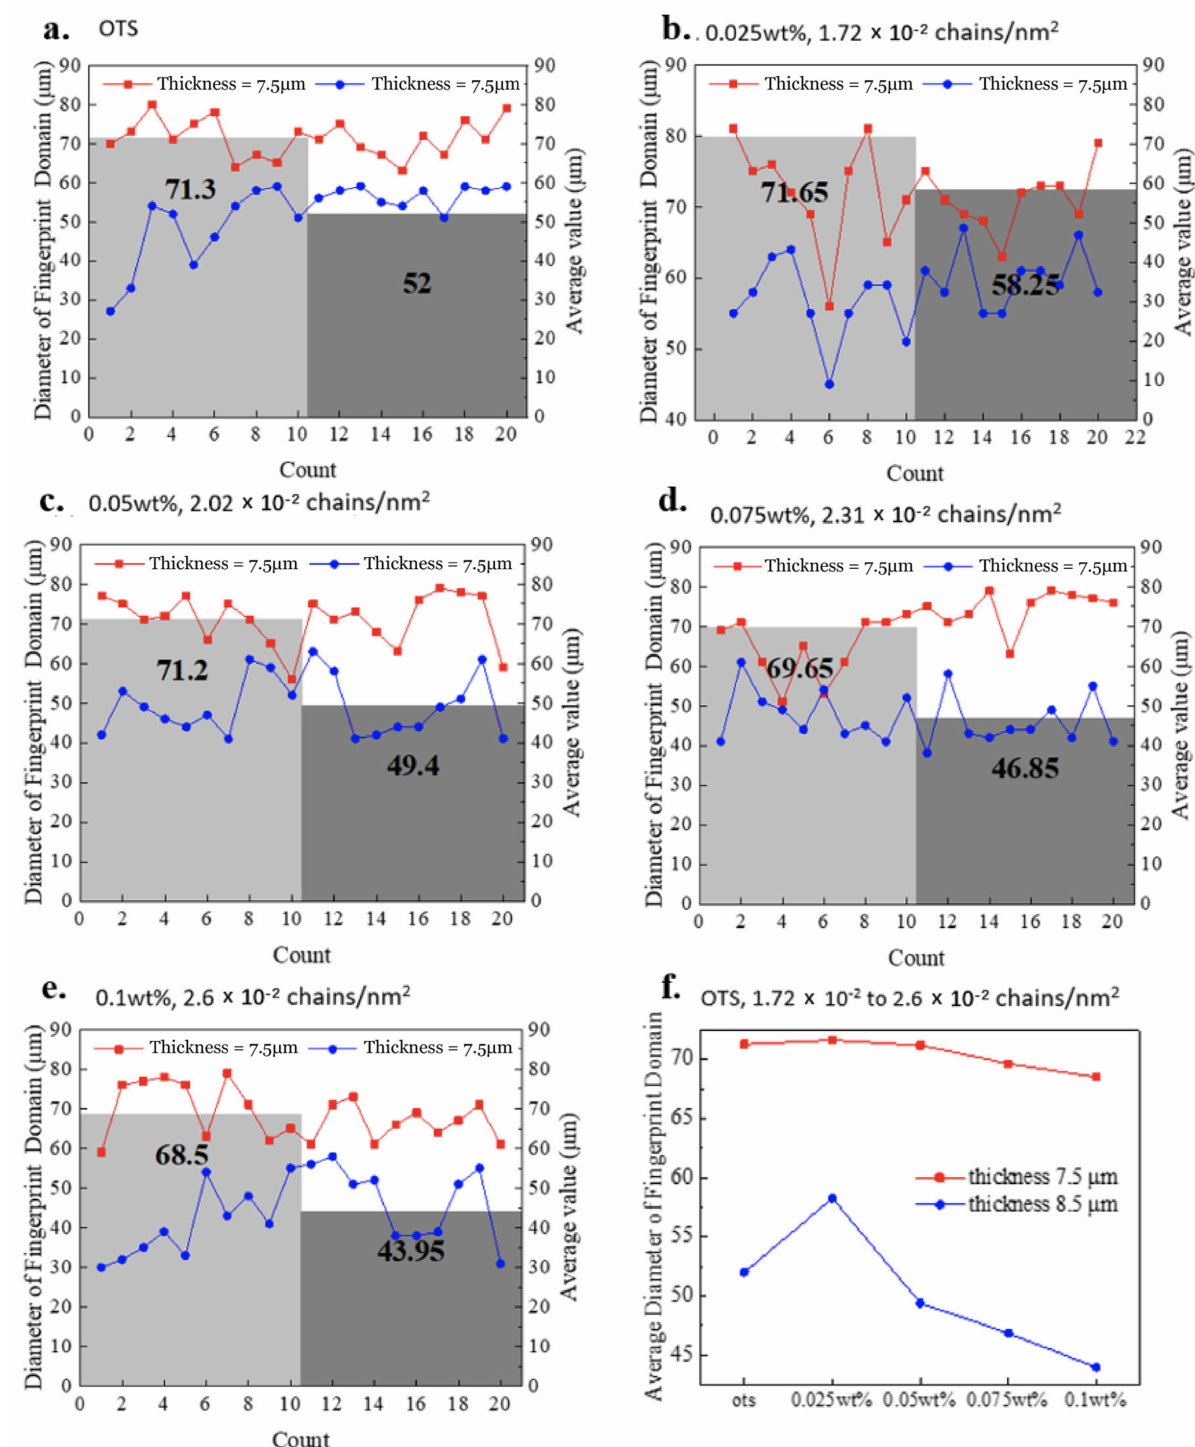
Figure 3. The average size of fingerprint domain in cells of 7.5 µ m and 8.5 µ m thicknesses. The top surface of cell is always OTS-modified. The condition on bottom surfaces varies: ( a ) OTS-modified; PMMAZO-modified with different concentrations and grafting densities ( b ) 0.025wt%, 1.72 × 10 − 2 chains/nm 2 ; ( c ) 0.05wt%, 2.02 × 10 − 2 chains/nm 2 ; ( d ) 0.075wt%, 2.31 × 10 − 2 chains/nm 2 ; ( e ) 0.1wt%, 2.6 × 10 − 2 chains/nm 2 . ( f ) The trend of fingerprint domain size with surface conditions.